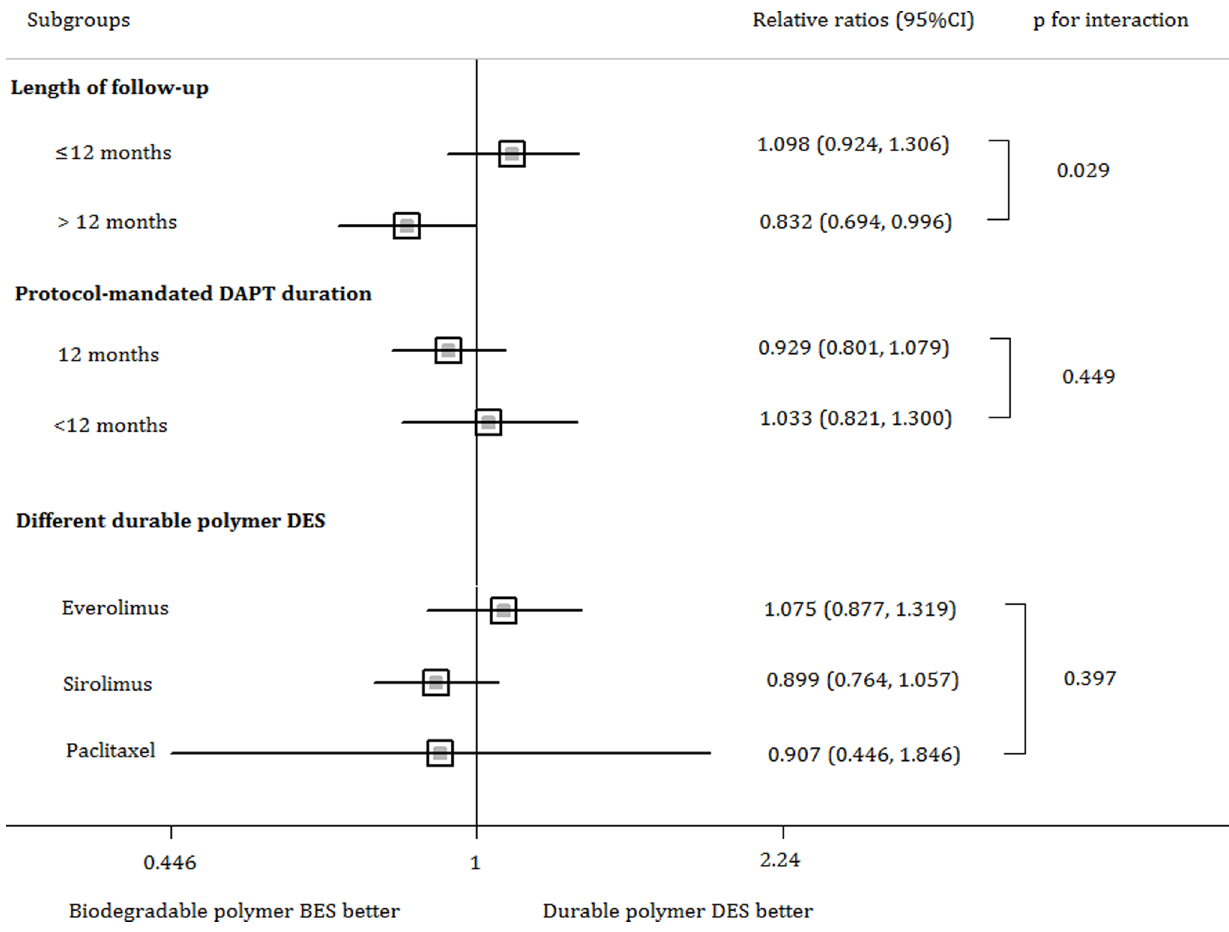
Figure 4. Subgroup analysis on MACE associated with biodegradable polymer BES versus durable polymer DES. The squares and the horizontal lines indicate the relative risks and the 95% confidence intervals for each subgroup. MACE: major adverse cardiac events; BES: biolimus- eluting stents; DES: drug-eluting stents.